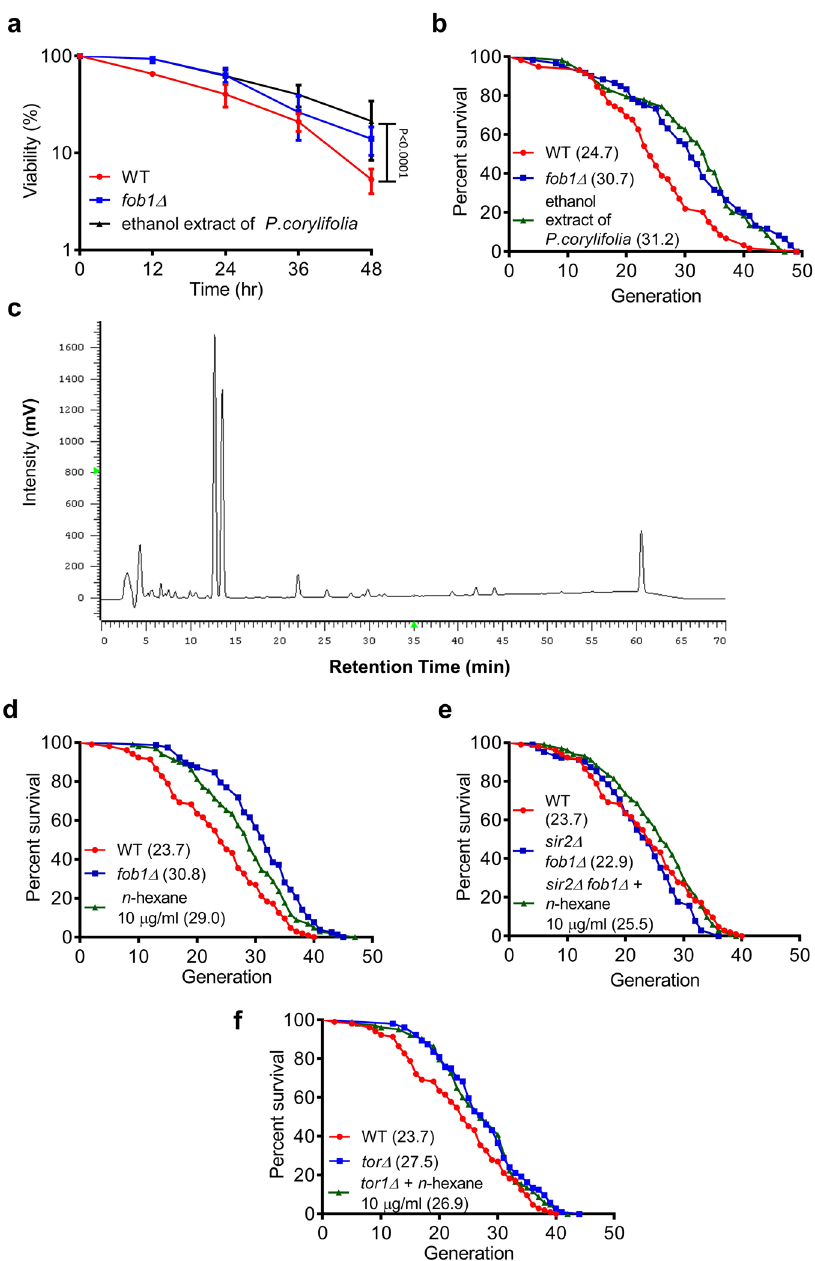
Fig. 1 Ethanol extract of Psoralea corylifolia extends the replicative lifespan of Saccharomyces cerevisiae . a Viability curve of the haploid MEP strain ZHY1 in liquid with a 10 μ g/ml ethanol extract of P.corylifolia or DMSO, the mutation of fob1 Δ is known to increase RLS ( n = 3). b The RLS was determined by micromanipulating individual yeast cells on YEPD with or without the ethanol extract of P. corylifolia . The mean for WT = 24.7 generations ( n = 59); fob1 Δ = 30.7 generations ( n = 60); and the P. corylifolia ethanol extract at 10 μ g/ml = 31.2 generations ( n = 59). c Column: MIGHTYSIL RP-18, 5 μ m. Eluents: solvent A: 0.1% formic acid — acetonitrile and solvent B: 0.1% formic acid – water. Elution pro fi le: 0 – 20 min, 60 – 50% B (40 – 50% A); 20 – 35 min, 50 – 40% B (50 – 60% A); 35 – 45 min, 40 – 30% B (60 – 70% A); 45 – 55 min, 30 – 20% B (70 – 80% A); 55 – 60 min, 60 – 50% B (40 – 50% A); 70 min, stop. Detection: UV at 245 nm. The RLS was determined by micromanipulating individual yeast cells on YEPD with or without the n- hexane extract of P. corylifolia . d The mean for WT = 23.7 generations ( n = 104); fob1 Δ = 30.8 generations ( n = 78); and the n -hexane extract of P. corylifolia at 10 μ g/ml = 29.0 generations ( n = 96). e The mean for WT = 23.7 generations ( n = 104); sir2 Δ fob1 Δ double deletion strain ( sir2 Δ fob1 Δ ) = 22.9 generations ( n = 102); and sir2 Δ fob1 Δ double deletion strain with the n -hexane extract of P. corylifolia at 10 μ g/ml ( sir2 Δ fob1 Δ + n- hexane) = 25.5 generations ( n = 102). f The mean for WT = 23.7 generations ( n = 104); tor1 Δ = 27.5 generations ( n = 104); and tor1 Δ with the n -hexane extract of P. corylifolia at 10 μ g/ml ( tor Δ + n- hexane) = 26.9 generations ( n = 103). Data presented as mean ± SD from at least three biologically independent experiments. a p values were determined by two-way ANOVA (multiple comparisons). b , d – f p values were determined by the Gehan – Breslow – Wilcoxon test (see also Supplementary Fig. 14). Source data are provided as a Source data fi